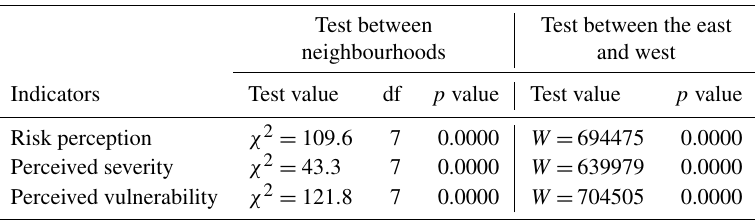
Table 5. Results of Wilcoxon and Kruskal–Wallis tests testing the spatial differences in risk perception. W indicates the Wilcoxon rank sum test and χ 2 the value of Kruskal–Wallis’s chi-squared